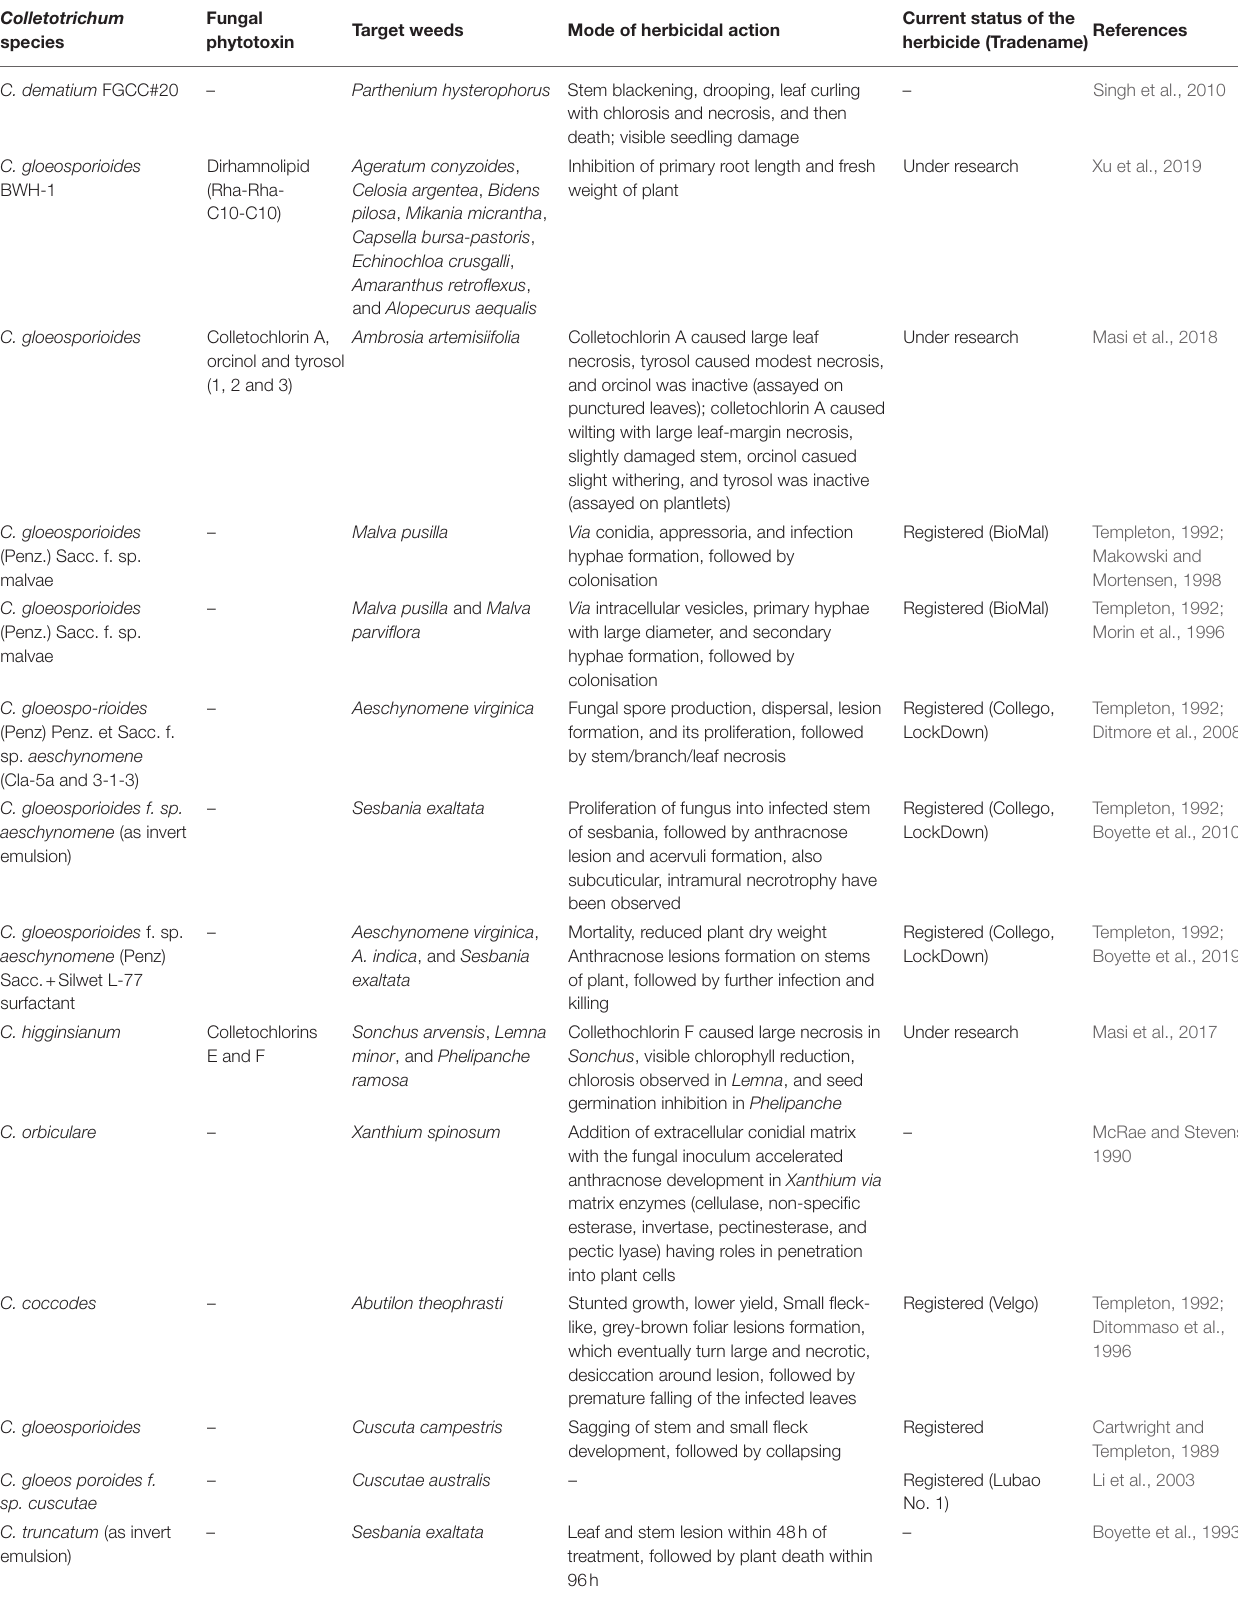
TABLE 1 | Fungi-based bioherbicides derived from Colletotrichum